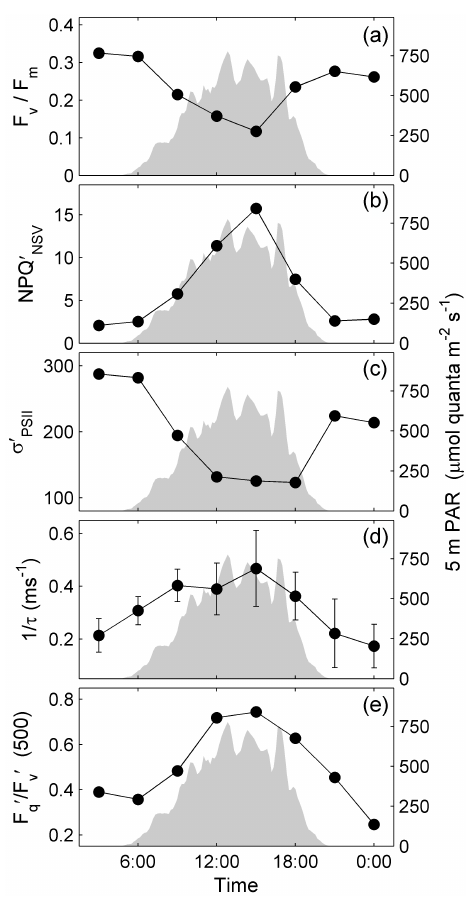
Figure 6. Diurnal changes in PSII photophysiological parameters derived from FRRF measurements. Panel (a) F v /F m in the dark- regulated state at each TP. Panels (b) and (c) show the normalized Stern–Volmer quenching, NPQ NSV , derived as F (cid:48) o /F (cid:48) v (McKew et al., 2013), and the functional absorption cross section, σ (cid:48) both estimated for in situ light availability at each TP. Values in (b) and (c) were calculated by extrapolating between values derived for each light step of the FRRF steady-state light curves. Panel (d) shows estimates of the rate of reoxidation of Q A . Panel (e) shows estimates of photochemical quenching ( F (cid:48) q /F (cid:48) v ), indicating the fraction of open RCII (primary stable electron acceptor Q A oxi- dized) at a reference irradiance level of 500µmolquantam − 2 s − 1